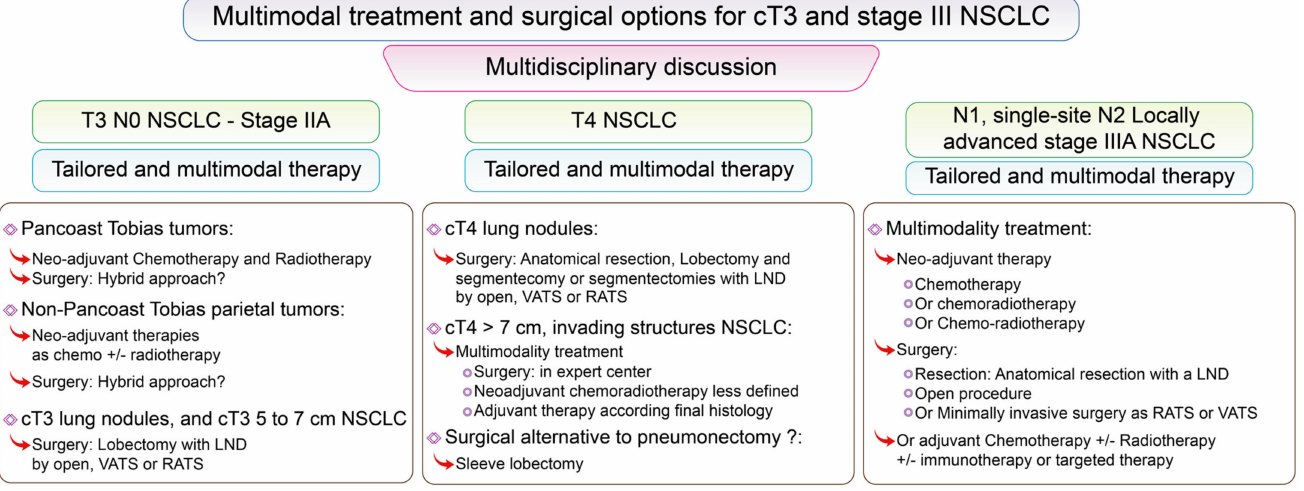
Figure 6. Multimodal treatment and surgical options for cT3 and stage III NSCLC. Surgical options according to lung cancer stage in the lung cancer Stage III group and cT3, according to the 8th Edition of the TNM Classification of Lung Cancer